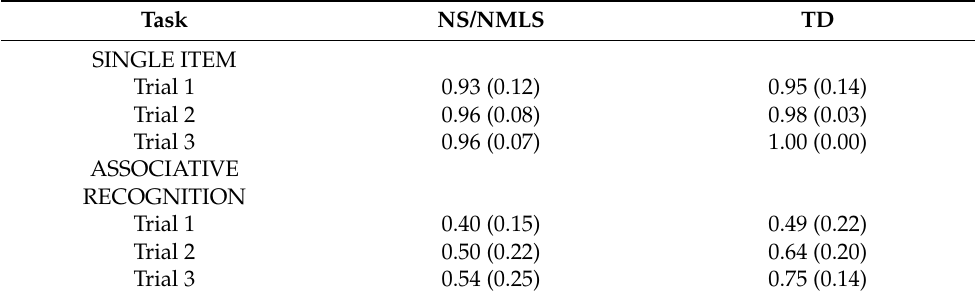
Table 3. Average (SD) proportion of accuracy of participants with NS/NMLS and TD on the single- item and associative recognition task per each